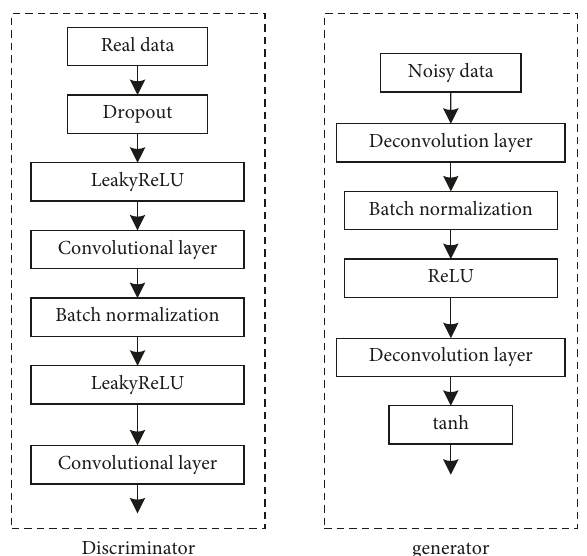
Figure 2: Model structures of the discriminator and generator in